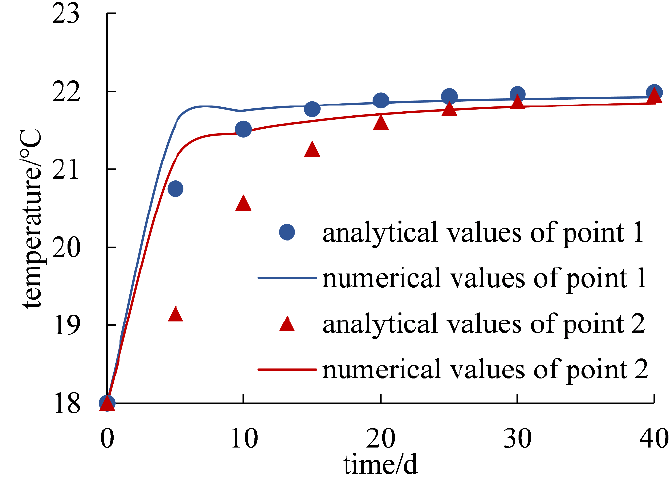
Figure 9. The comparison of analytical and numerical results.